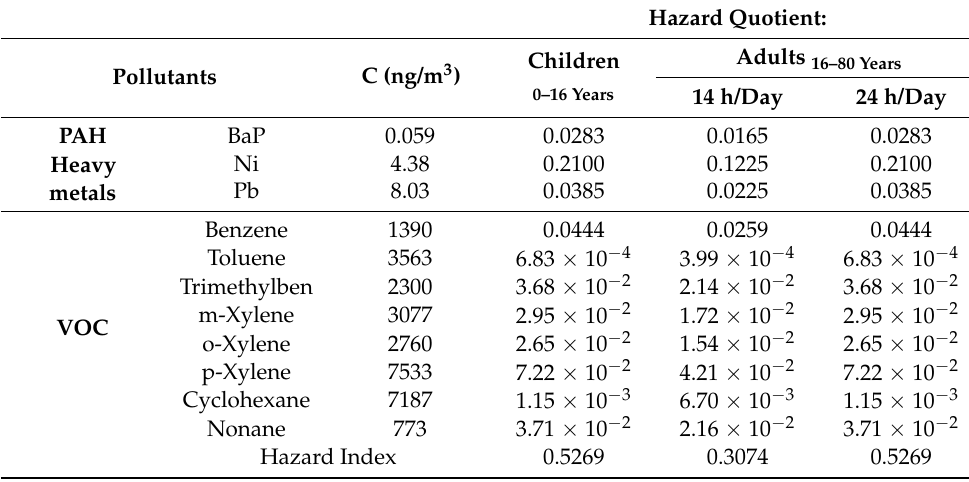
Table A12. Non-cancer risk assessment B.IV method (Megido,